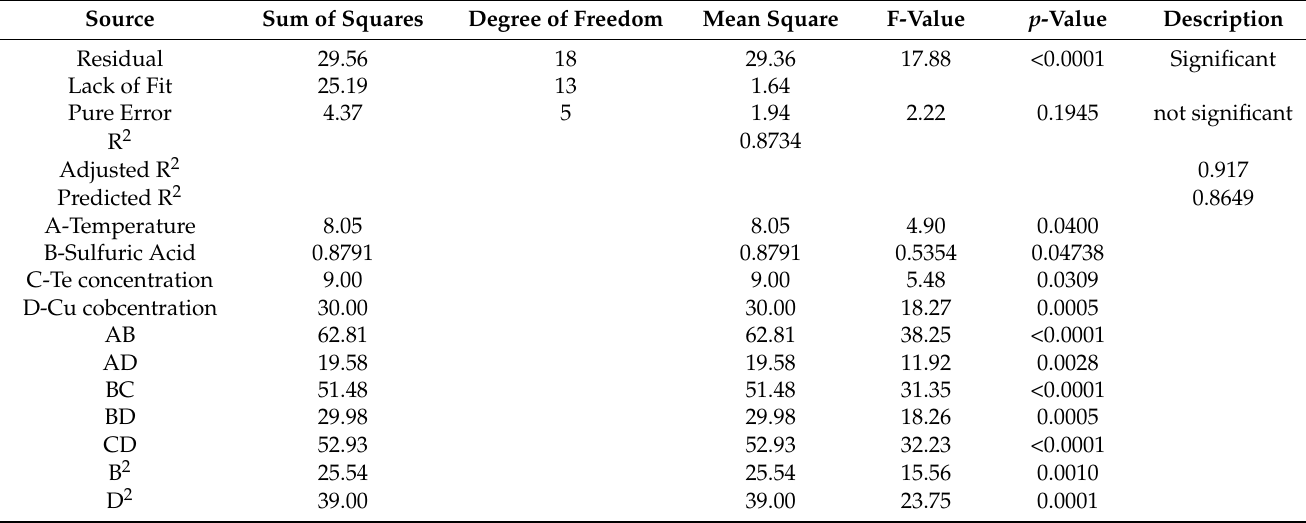
Table 5. Analysis of variance (ANOVA) and coefficient of determination for the suggested quadratic polynomial model for